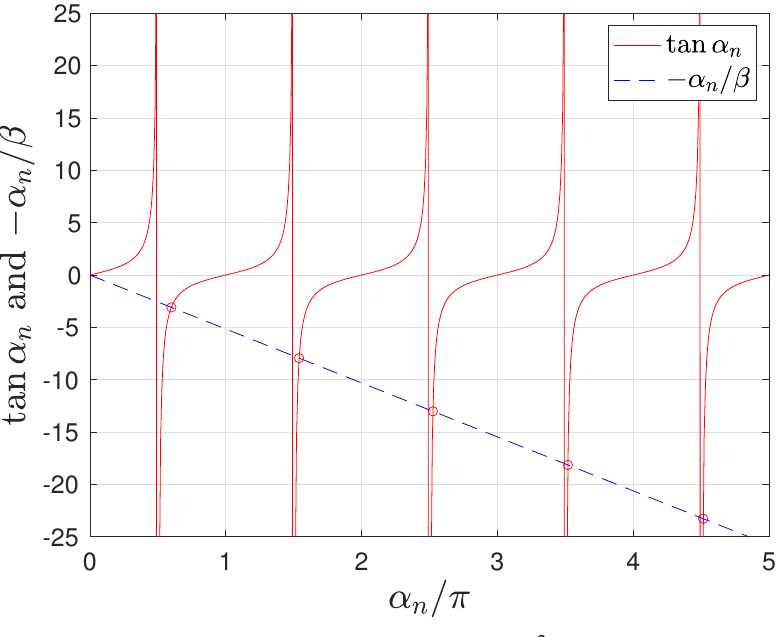
Figure 4. Characteristic values, α n , for β = 6.095 × 10 − 2